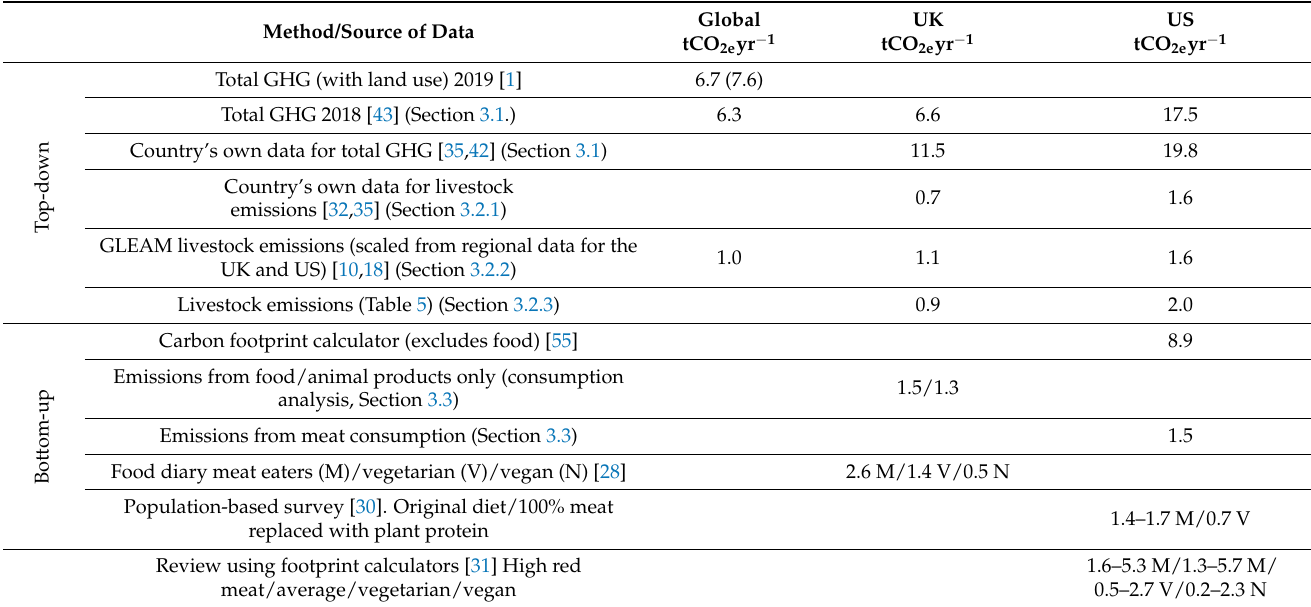
Table 6. Comparison of GHG footprints (per person per year) calculated here using different methods focused on the UK and the